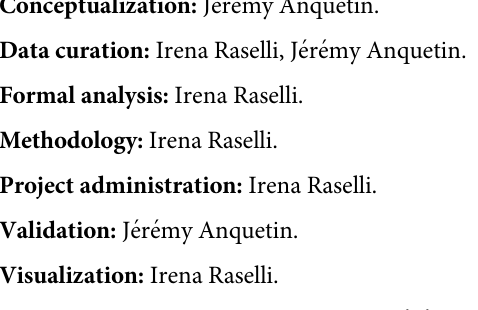
S2 Fig. Segmented skull of Plesiochelys bigleri (MJSN TCH007-252). Views: A: dorsal, B: ventral, C: anterior, D: posterior, E: medial, F: lateral.